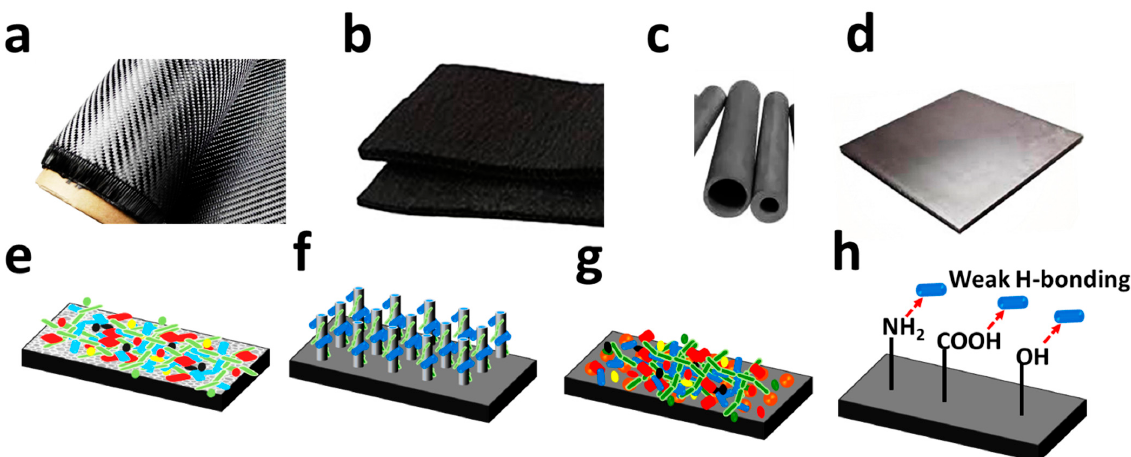
Figure 4. Commonly used carbon electrodes in BES and their modification techniques for improved performance: ( a ) carbon cloth; ( b ) carbon felt; ( c ) graphite column; ( d ) graphite plate; ( e ) porous electrodes; ( f ) micro–nano pillar fabricated on carbon substrate; ( g ) nanoparticle-modified electrode; ( h ) functional group modified electrode.